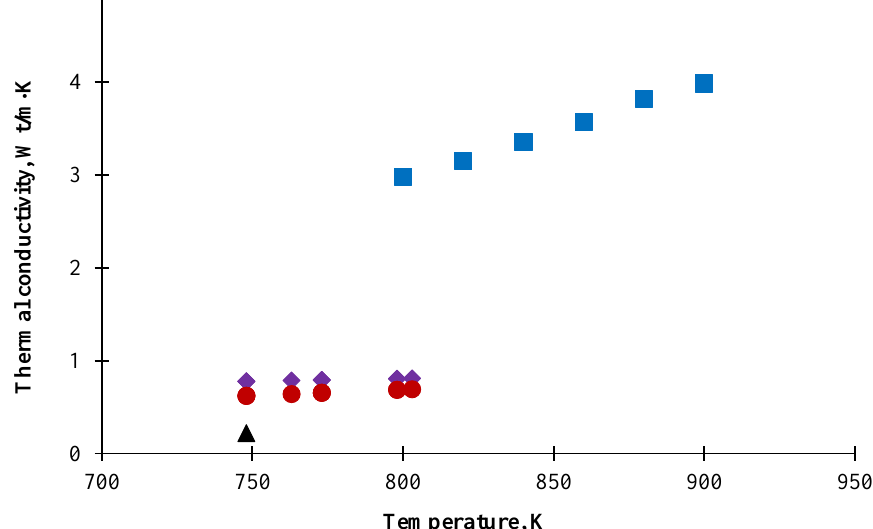
Figure 1. FLiNaK thermal conductivity data obtained by Khokhlov ( ⯁ ), An ( ● ), Ueki ( ▲ ) and Ewing ( ■ ).